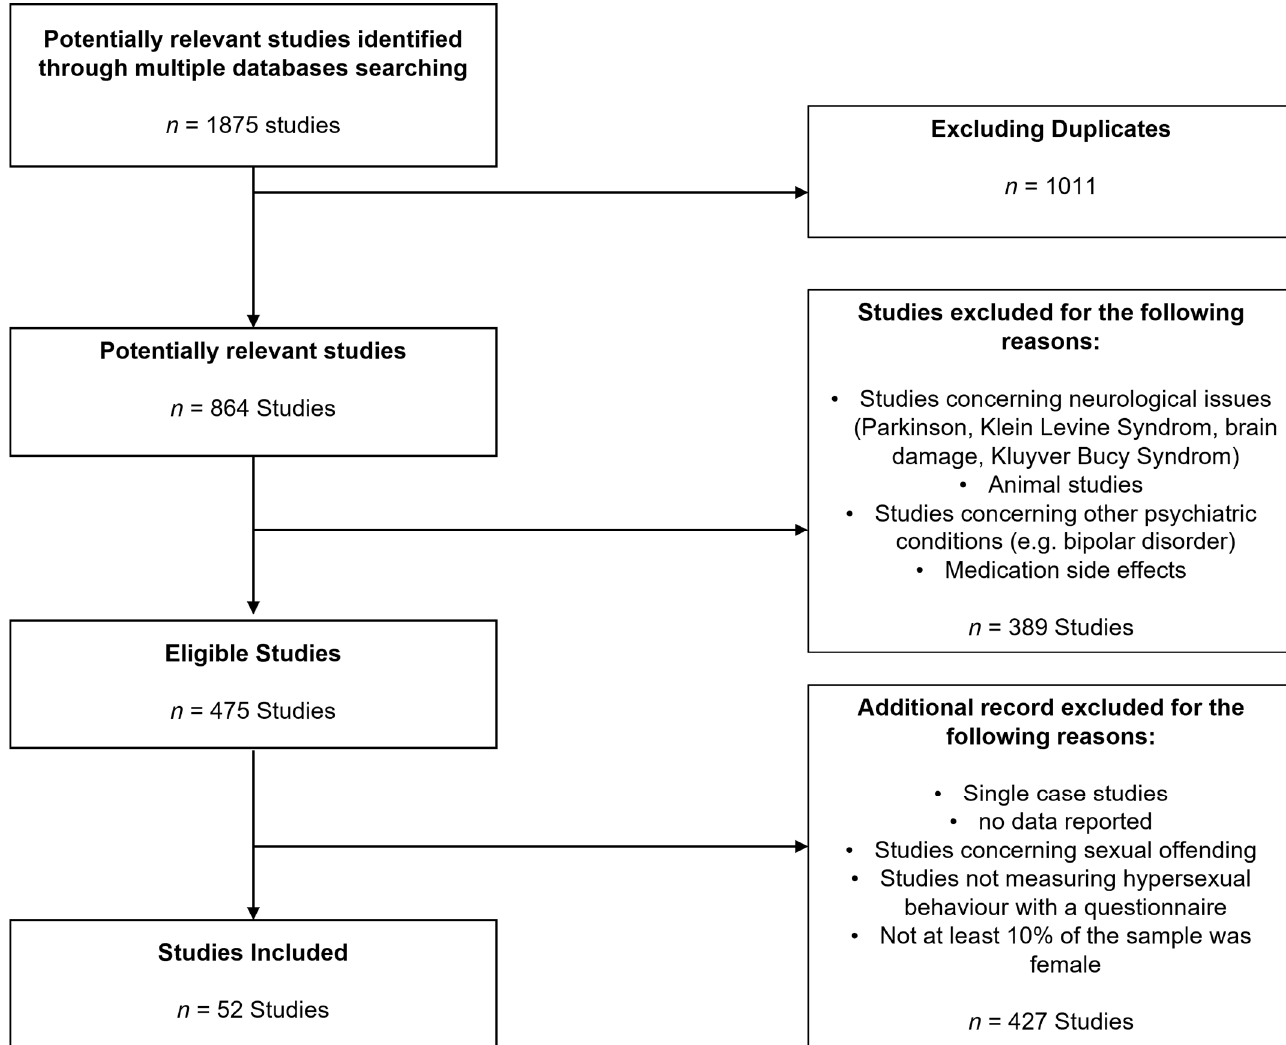
Figure 1. Preferred Reporting Items for Systematic Reviews Flow Diagram (PRISMA).